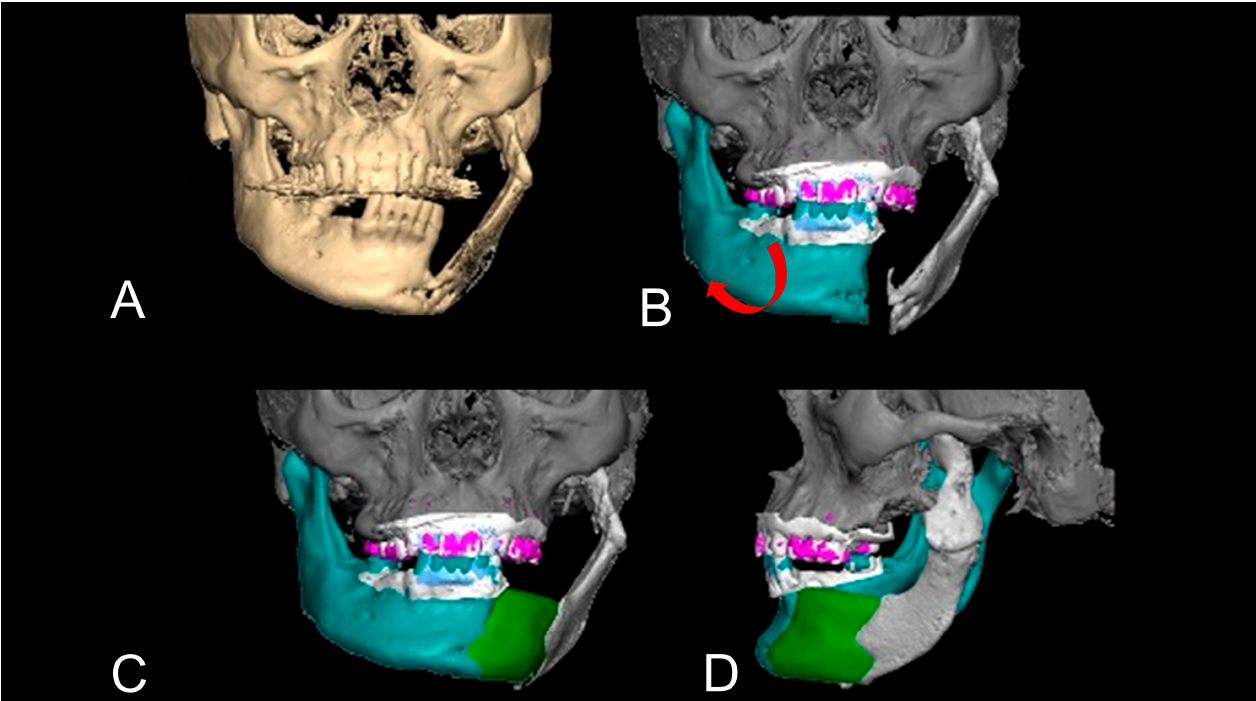
Figure 8. Complicated mandibular deviation with the application of the dental cast model. This was a case of a left segmental mandibular defect due to a tumour resection with radical neck dissection. The defects were reconstructed with a scapular flap and a surgical plate simultaneously (Case